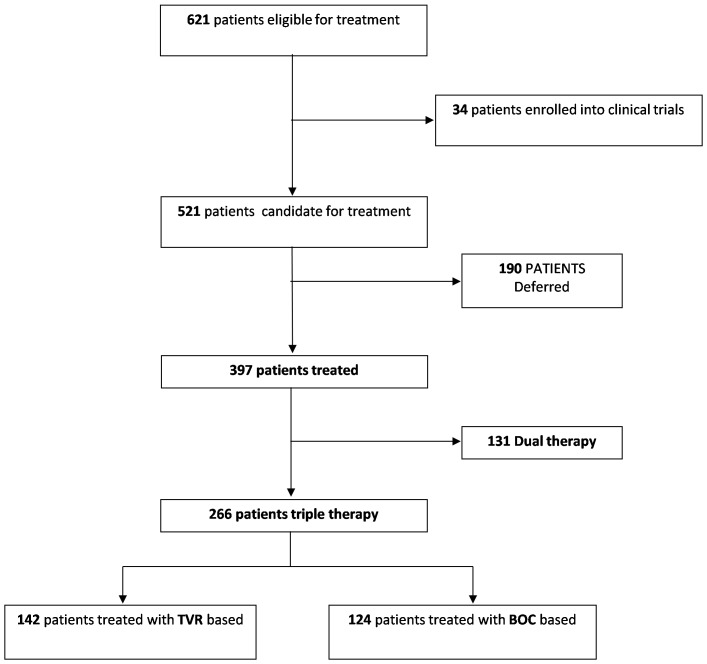
Patient disposition in the study.